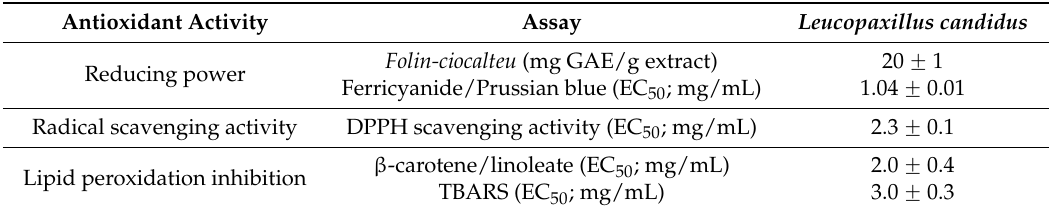
Table 3. Antioxidant activity of the methanolic extracts (mean ˘